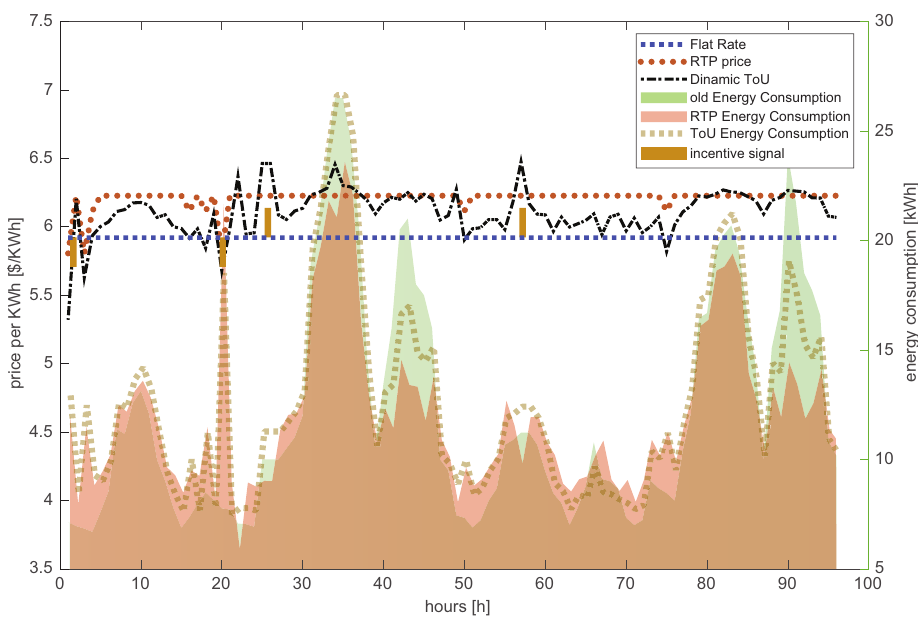
Figure 21. Demand variation/four